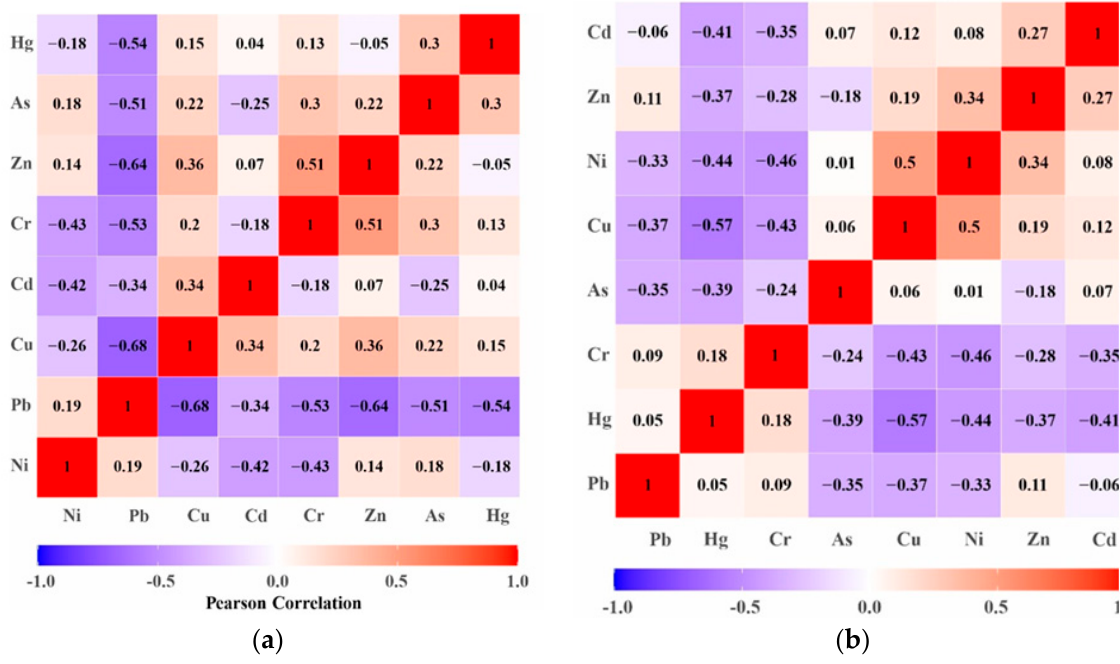
Figure 8. Correlation coefficient heat map of heavy metals in the sediments of Yueliang Lake ( a ) the surface sediments, ( b ) the sediment core.